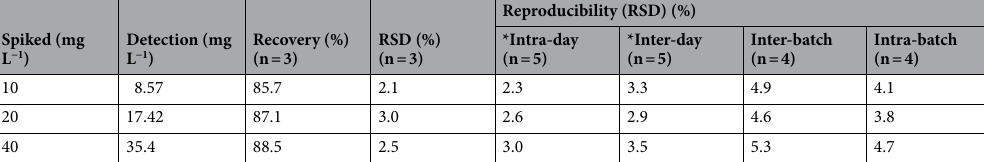
Table 1. Recovery and RSD for developed MISPE-HPLC method. *Intra-day (0, 2, 4, 8, 24 h), Inter-day (5 consecutive days).